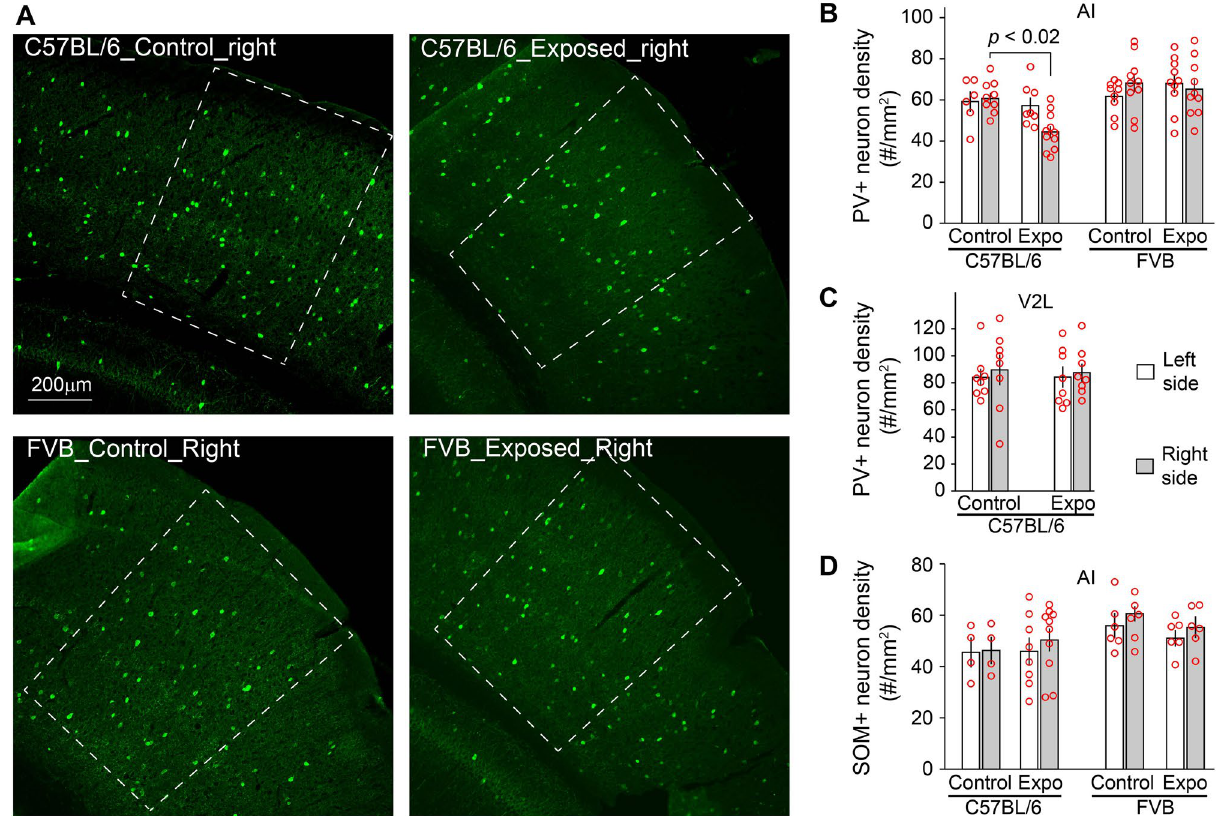
was significantly reduced in the right AI of C57BL/6 but not FVB mice 5 days after noise exposure. ( C ) The reduction of PV+ neuron density was not observed in lateral area of the secondary visual cortex (V2L). ( D ) The density of SOM+ neurons was not significantly altered in AI of C57BL/6 or FVB mice 5 days after noise